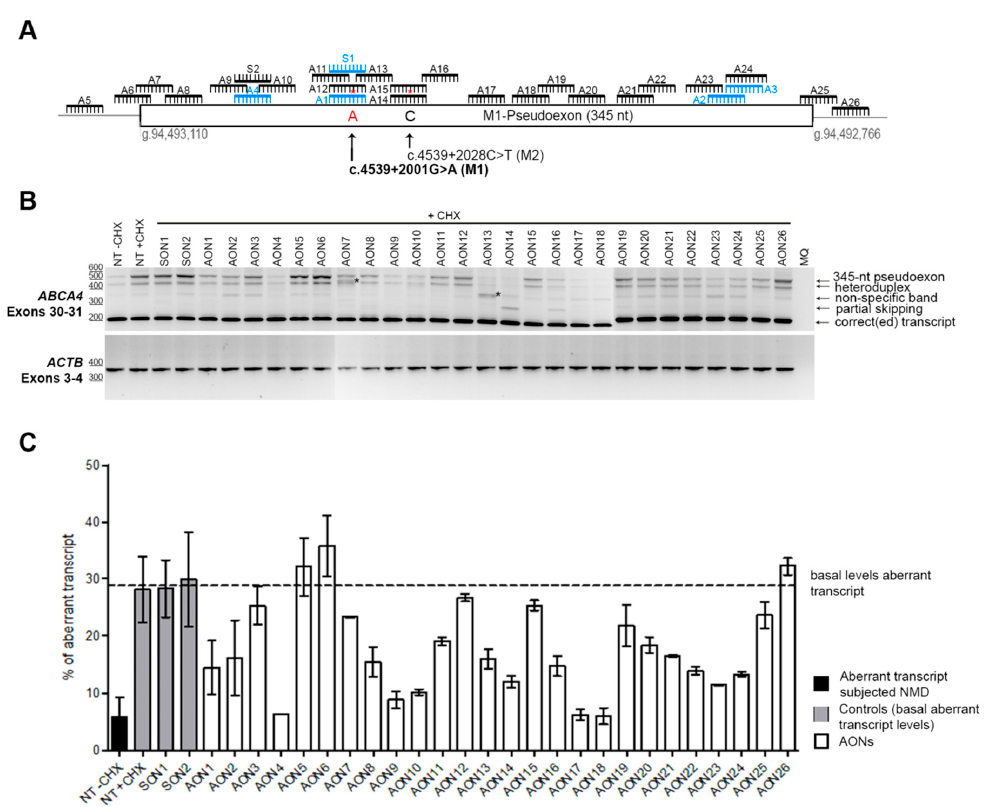
Figure 1. AON-based pseudoexon skipping efficacy. ( A ) Schematic representation of the 345-nt pseudoexon insertion caused by the c.4539+2001G>A mutation and the location of the 26 AONs and the 2 sense oligonucleotides (SONs). Blue oligonucleotides refer to previously studied molecules [18]. Red asterisks represent mismatches with the pseudoexon sequence created only by the c.4539 + 2001G > A mutation (namely an A at position c.4539 + 2001 and a C at position c.4539 + 2028). ( B ) Representative image of an RT-PCR performed on patient-derived photoreceptor precursor cells (PPCs) upon AON treatment. ACTB was used to normalize samples. An heteroduplex band was observed in all samples, containing the correct and the pseudoexon-included transcripts. AON-derived partial skipping was observed in samples AON14 and AON16. Double bands highlighted with an * (lanes AON7 and AON13) indicate artifacts derived from the AON treatment, and splice sites could not be identified upon Sanger sequencing. In most of the lanes, we identified a PCR artifact (nonspecific band). ( C ) Percentage of aberrant transcript after semiquantification. NT: Nontreated; CHX: Cycloheximide. Error bars indicate average ±